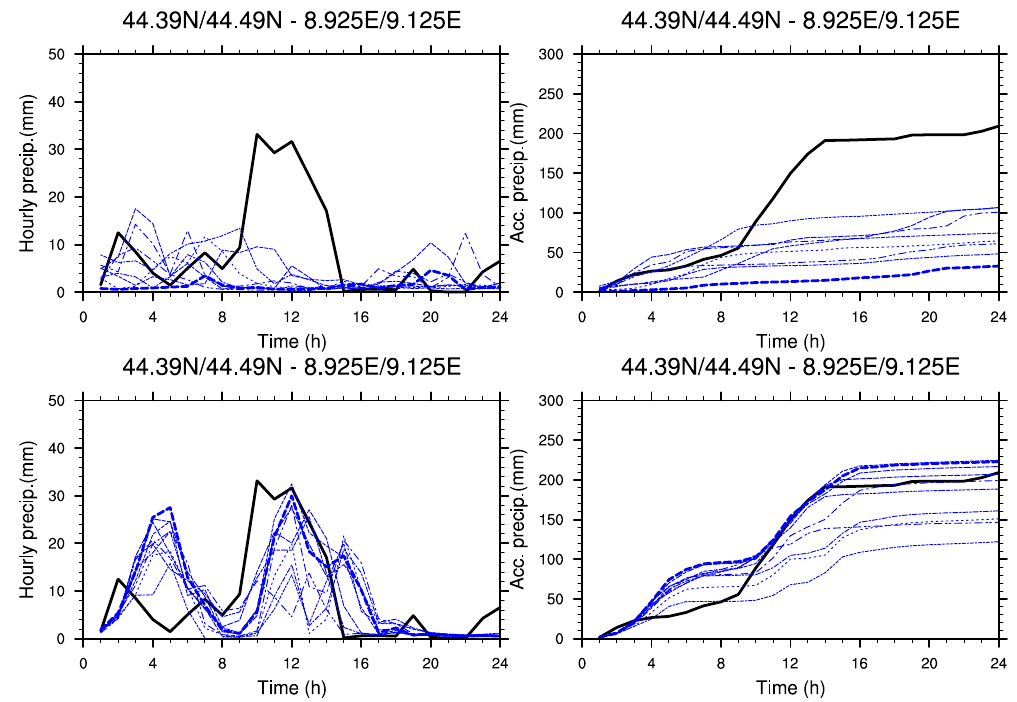
Figure 9. The temporal evolution of the 1h accumulated simulated rainfall (left panels) and 24h accumulated simulated rainfall (right panels) for the members of the AROME ensemble (top panels) and the members of the MNH-ARP-CT ensemble (bottom panels), over the Bisagno basin. The evolution of the observed rainfall is represented by the solid black line while the ensemble members appear in blue. The thickest blue line represents the evolution of the CTRL member of each